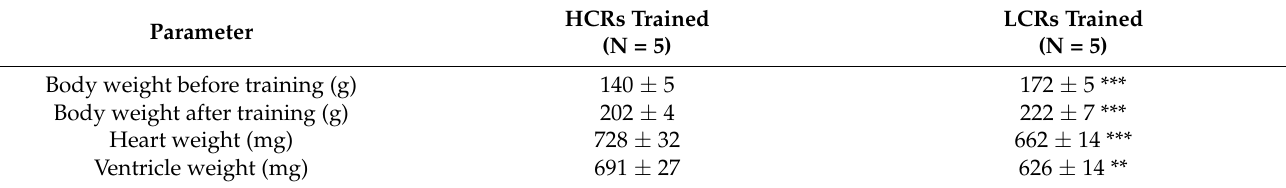
Table 1. Characteristics of LCR und HCR rats after 4 weeks of exercise